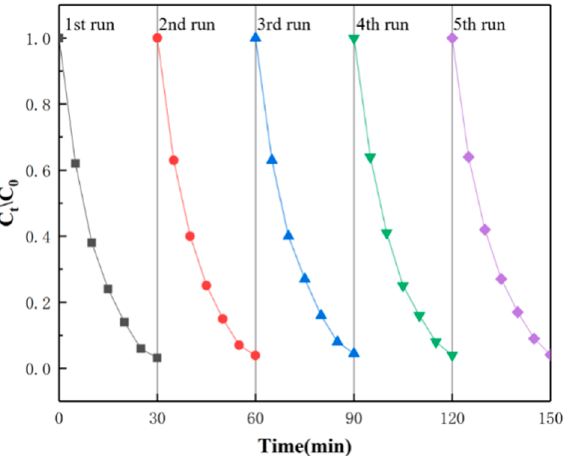
Figure 10. The reproducibility of the modified PCL-g-C 3 N 4 /CQDs electrospun membranes for deg- radation of AFB 1 for 5 cycles.